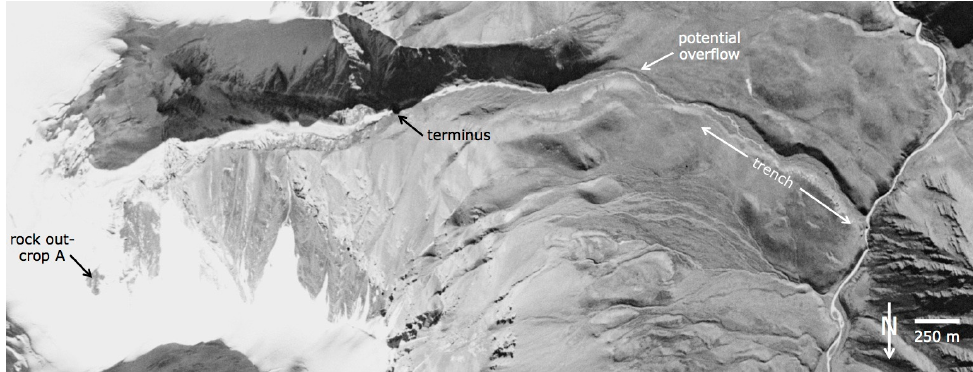
Figure 3. Corona image from 1964 showing the glacier being connected to its accumulation area and a glacier forefield that is free of any avalanche deposits. Note: South is up to highlight the relief. Image source: